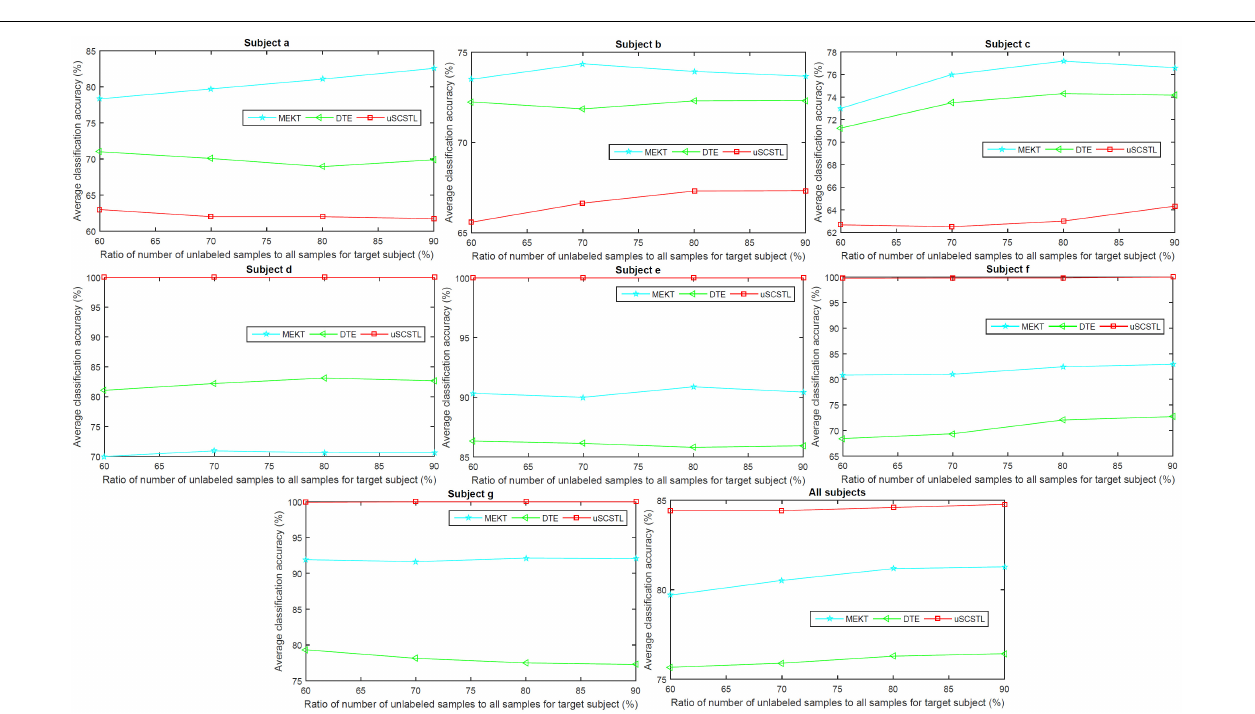
Frontiers in Neuroscience |